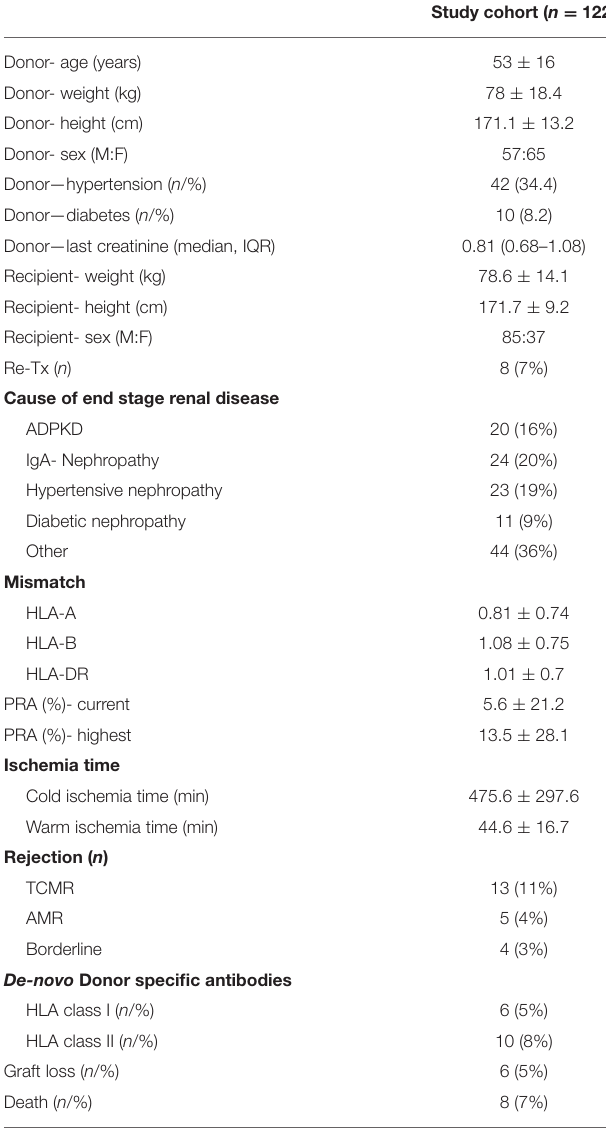
TABLE 1 | Baseline characteristics of the study